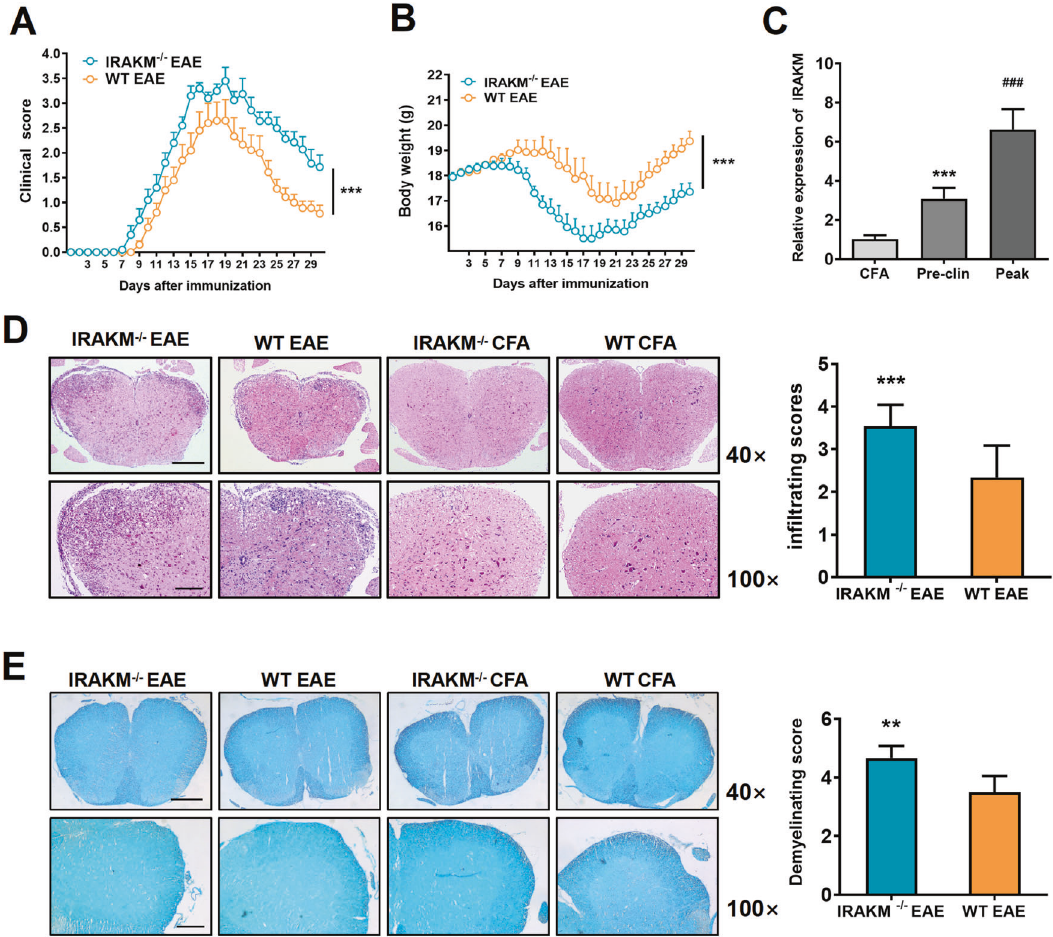
Fig. 2 IRAK-M de fi ciency deteriorates neurobehavioral symptoms and pathological changes in the EAE model. A Average clinical scores of IRAK-M − / − and WT EAE groups, respectively ( n = 12 per group). B The variation of body weight of IRAK-M − / − and WT EAE groups, respectively ( n = 12 per group). C Relative fold induction of IRAK-M mRNA in the development of WT EAE on day 10 and at peak disease compared to WT CFA on day 18 ( n = 5, respectively). *** P < 0.001 compared to the WT CFA group. ### P < 0.001 compared to WT EAE on day 10. D Representative images of H&E staining (upper panels on the left show a 4 × 10 magni fi cation of the whole spinal cord, scale bar: 500 µm; lower show a 10 × 10 magni fi cation of the anterior median region, scale bar: 200 µm). The right panel shows the evaluation of in fi ltrating degree ( n = 12 per group). E Representative images of LFB staining. The uncolored area in the anterior white matter indicates the area of axonal injury (upper panels on the left show a 4 × 10 magni fi cation of the whole spinal cord, scale bar: 500 µm; lower show a 10 × 10 magni fi cation of the anterior median region, scale bar: 200 µm). The right panel shows the evaluation of the demyelination degree ( n = 12 per group). Results were normalized to GAPDH. All results were from three representative experiments. Data show the mean ± SEM and were analyzed by an unpaired t